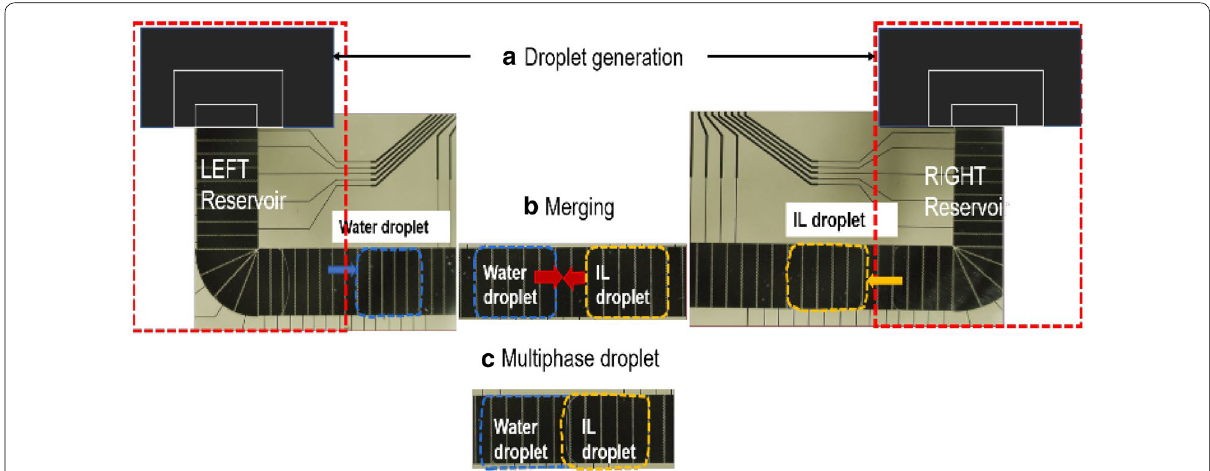
Fig. 4 Steps of an experiment: a generation of water and ionic liquid (IL) droplets from each reservoir, b merging the generated droplets, and c the multiphase droplet